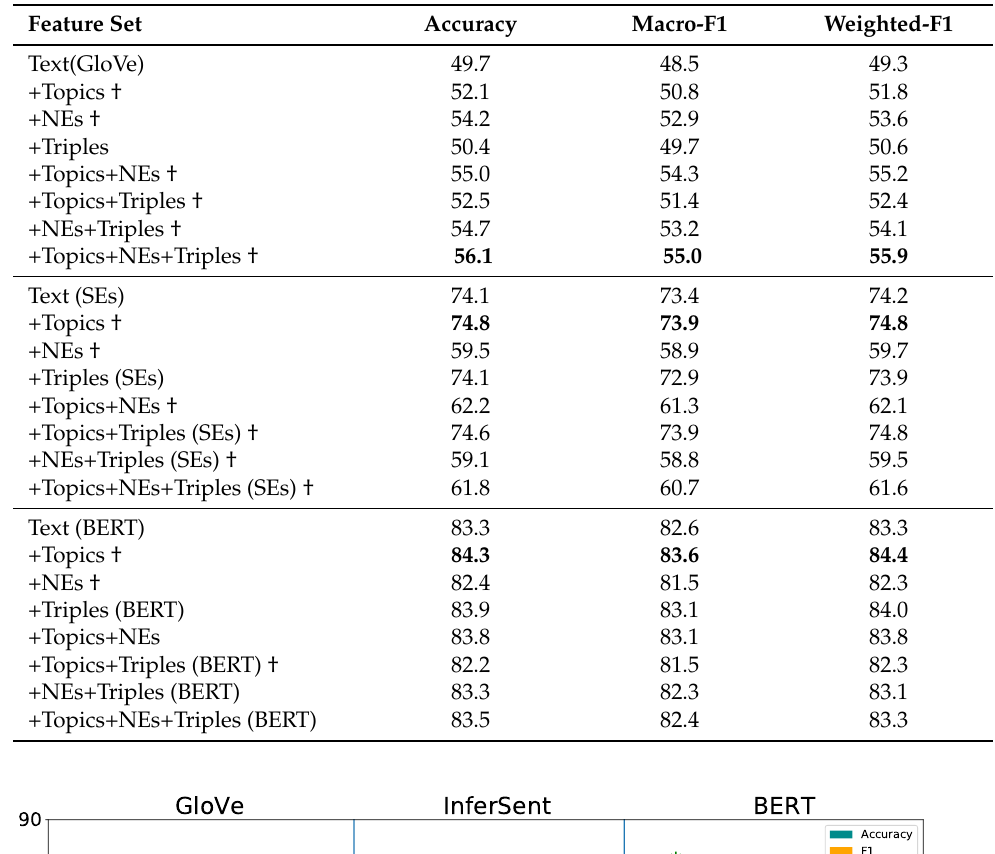
Table 4. News-feed classification results on the 20 News groups dataset. †s indicate statistically significant differences (using McNemar’s test) with reference to the baseline models. Note: SEs =